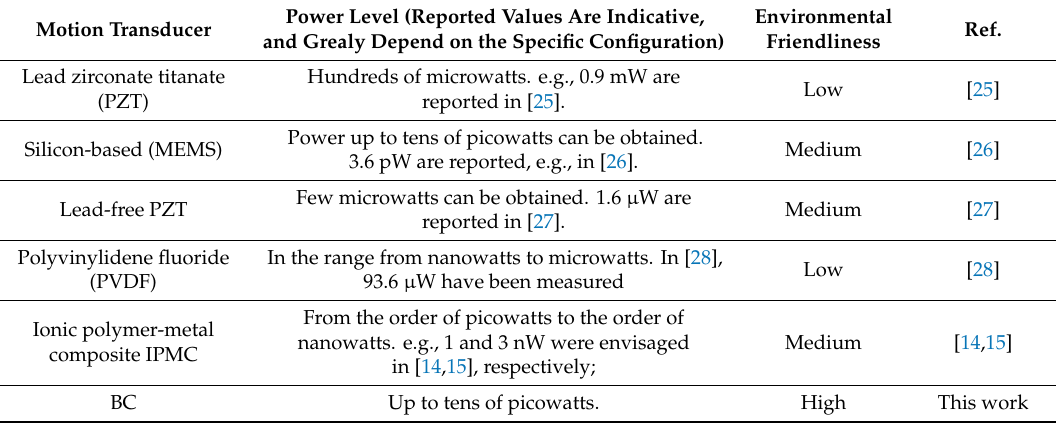
Table 3. Comparison of performance for several energy harvesters based on di ff erent technologies. Motion Transducer